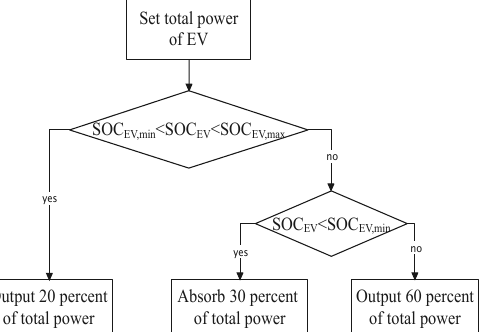
Figure 3. The scheduling strategy of